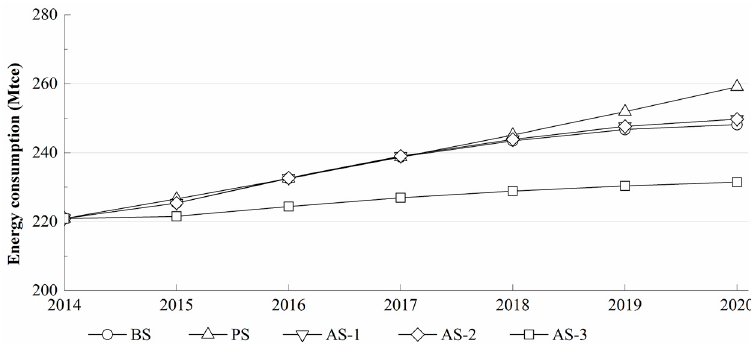
Figure 10. Household energy consumption scenario simulation.